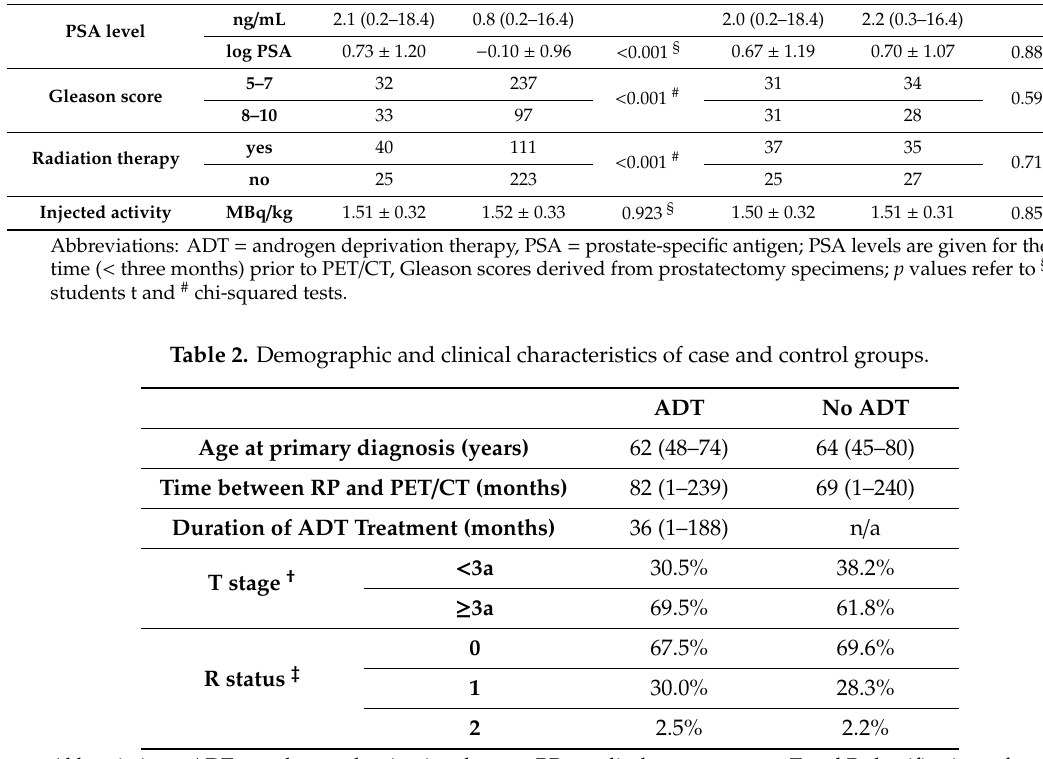
Table 1. Patient groups and covariates before and after Propensity score matching. All Patients Matched Groups